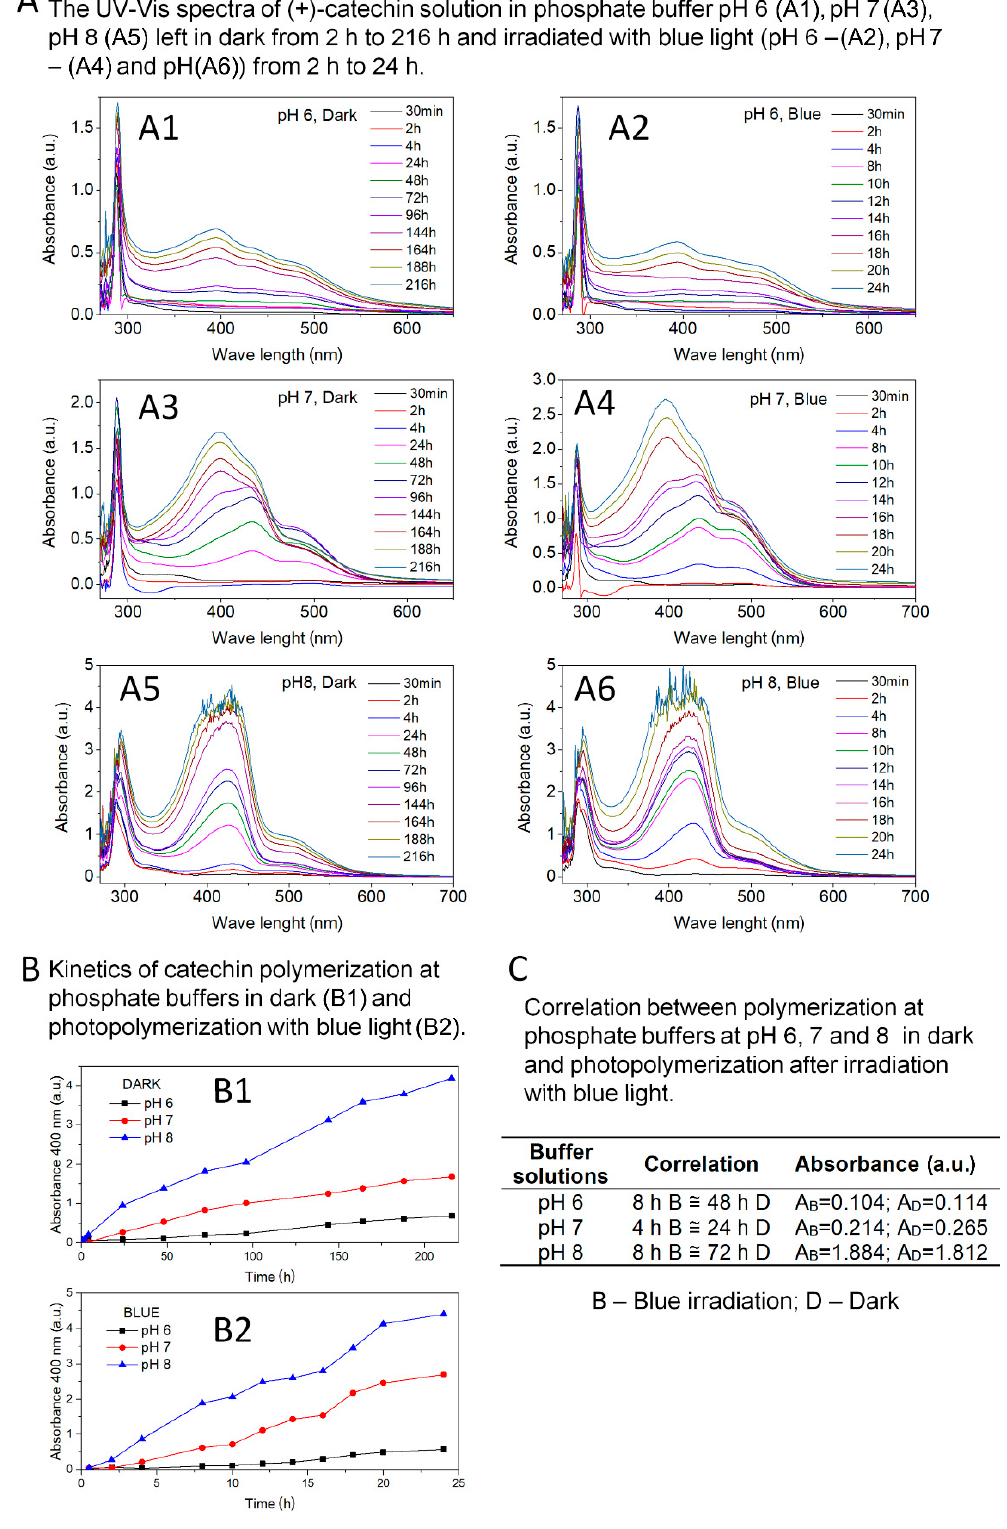
Figure 1. ( A ) The UV-Vis (Ultraviolet–visible) spectra of ( + )-catechin solution in phosphate bu ff er pH 6 ( A1 ), pH 7 ( A3 ), pH 8 ( A5 ) left in the dark from 2 h to 216 h and irradiated with blue light (pH 6— A2 , pH 7— A4 , and pH 8— A6 ) from 2 h to 24 h. ( B ) Kinetics of catechin polymerization in phosphate bu ff ers in the dark ( B1 ) and photopolymerization after irradiation with blue light ( B2 ). ( C ) Correlation between polymerization in phosphate bu ff ers in the dark and photopolymerization after irradiation with blue light.